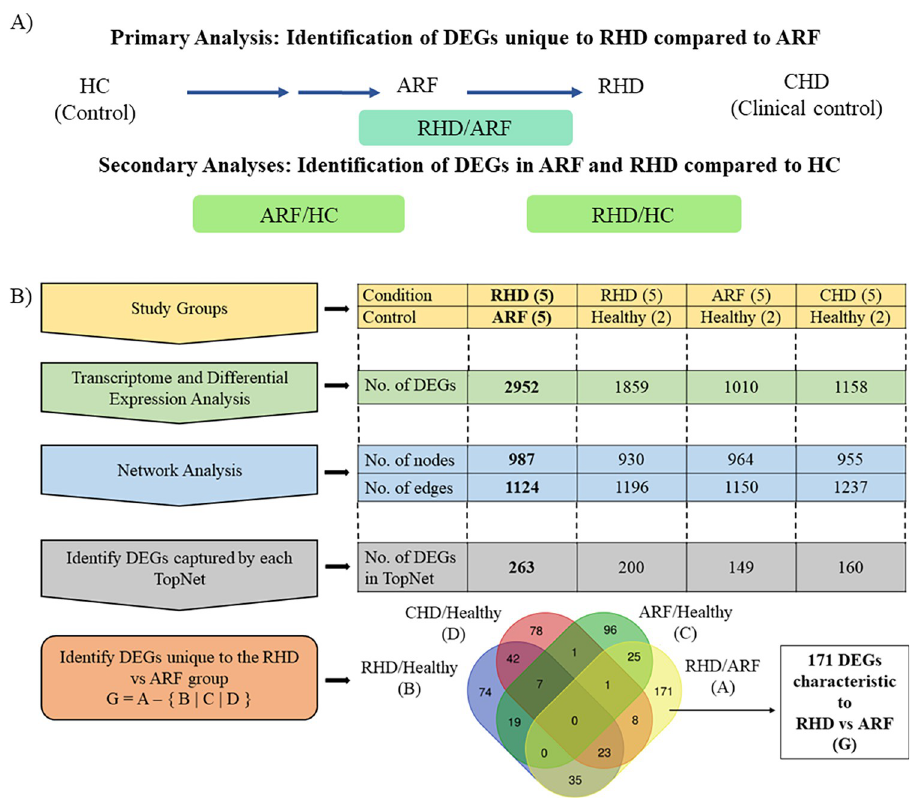
Fig 1. Overview of the study. (A) Relationship between the groups of analysis. (B) Overview of the workflow and results. Functionally significant DEGs characteristic to the RHD vs. ARF group obtained from a sensitive network mining approach were identified by excluding DEGs from sub-networks of RHD vs. Healthy, ARF vs. Healthy, and CHD vs. Healthy